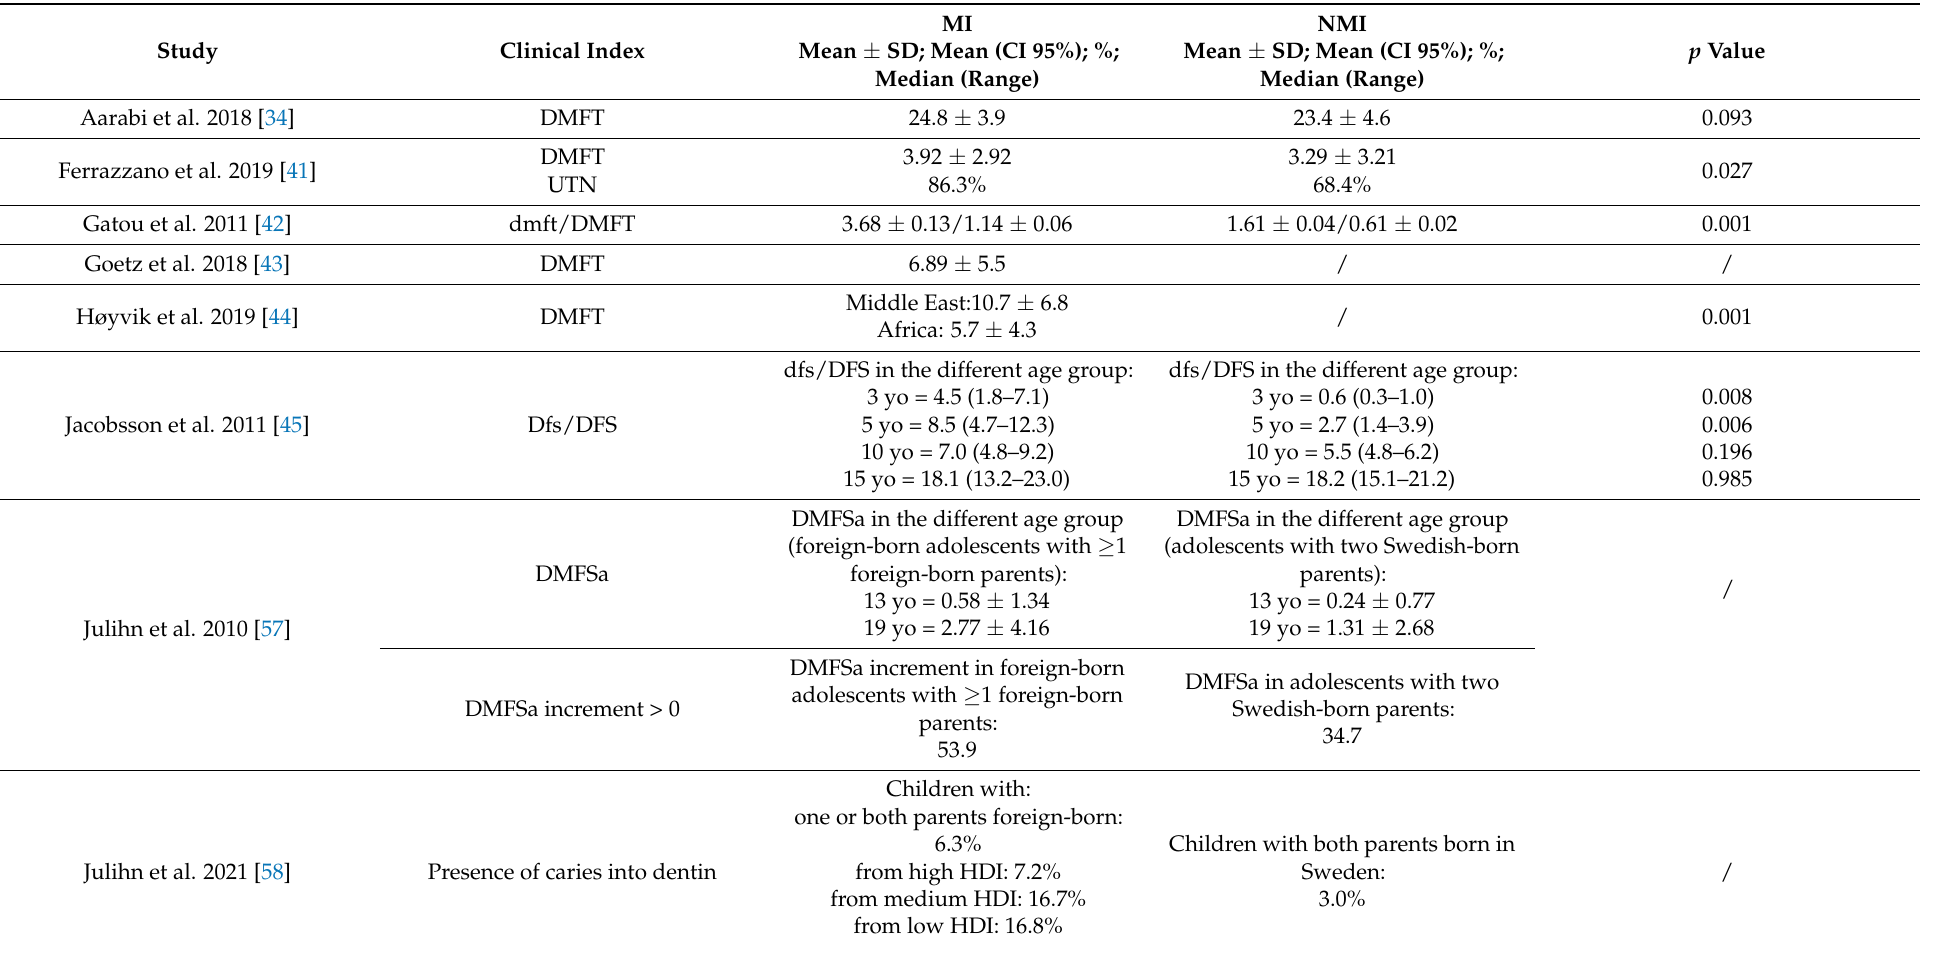
Table 9. Dental caries in MI and NMI: dmft/DMFT, UTN, dsf/DFS, DMFSa. Mean ± SD, Mean (CI 95%), %, Median (range)